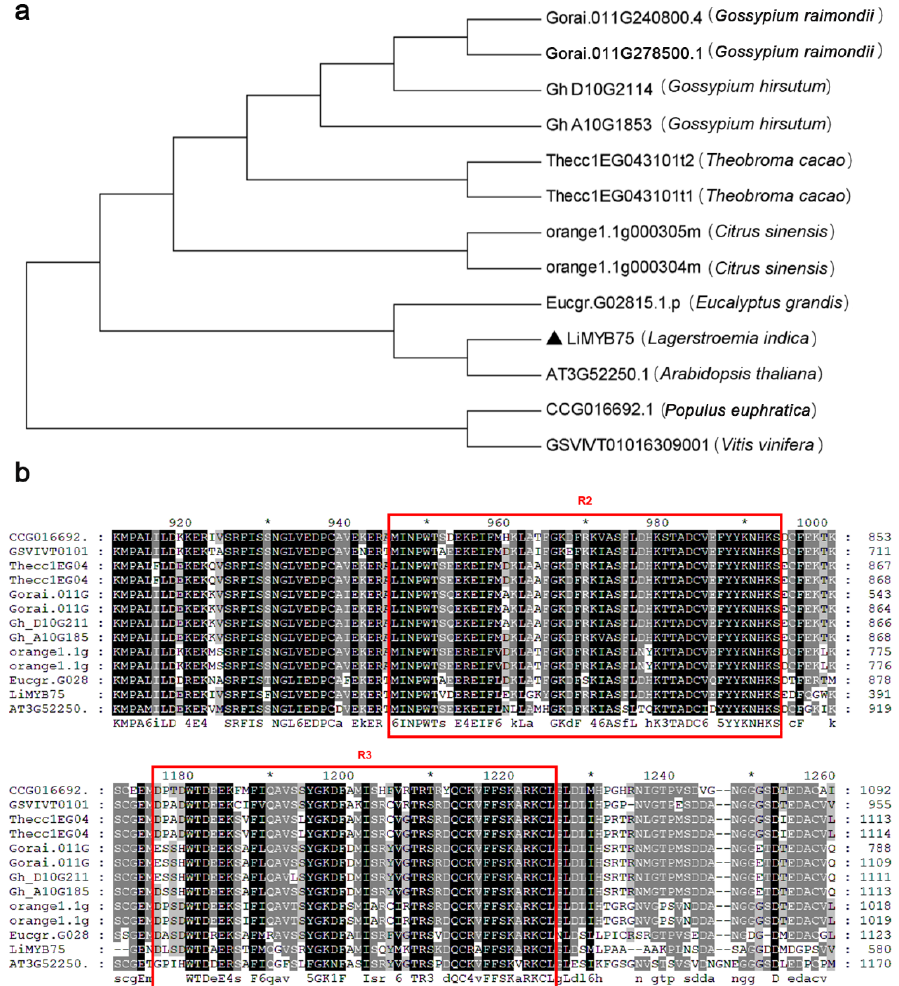
Figure 4. Phylogenetic analysis ( a ) and multiple sequence alignment ( b ) of the LiMYB75 gene with MYB transcription factors from other species. Sequences of the MYB gene from A. thaliana , V. vinifera , T. cacao , E. grandis , P. euphratica , G. hirsutum , G. raimondii, and C. sinensis were downloaded from the Plant Transcription Factor Database. The two red boxes indicate the R2 and R3 domains, respectively.